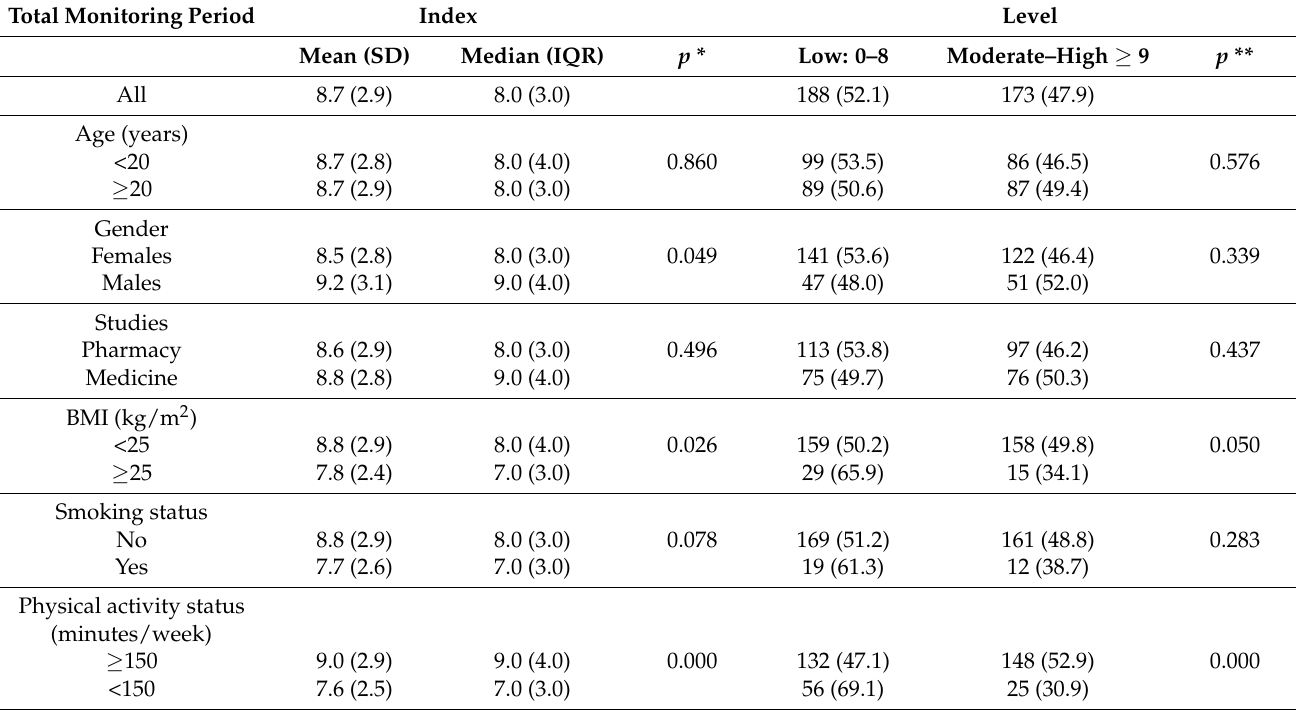
Table 3. Scores and levels of the AMD index (total monitoring